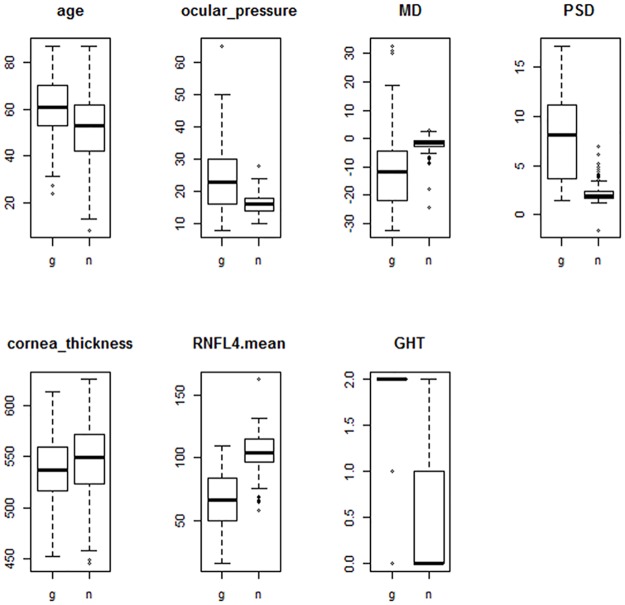
Box plots for selected features (g: Glaucoma, h: Health control).All features show a large difference of median values between glaucoma and healthy controls.